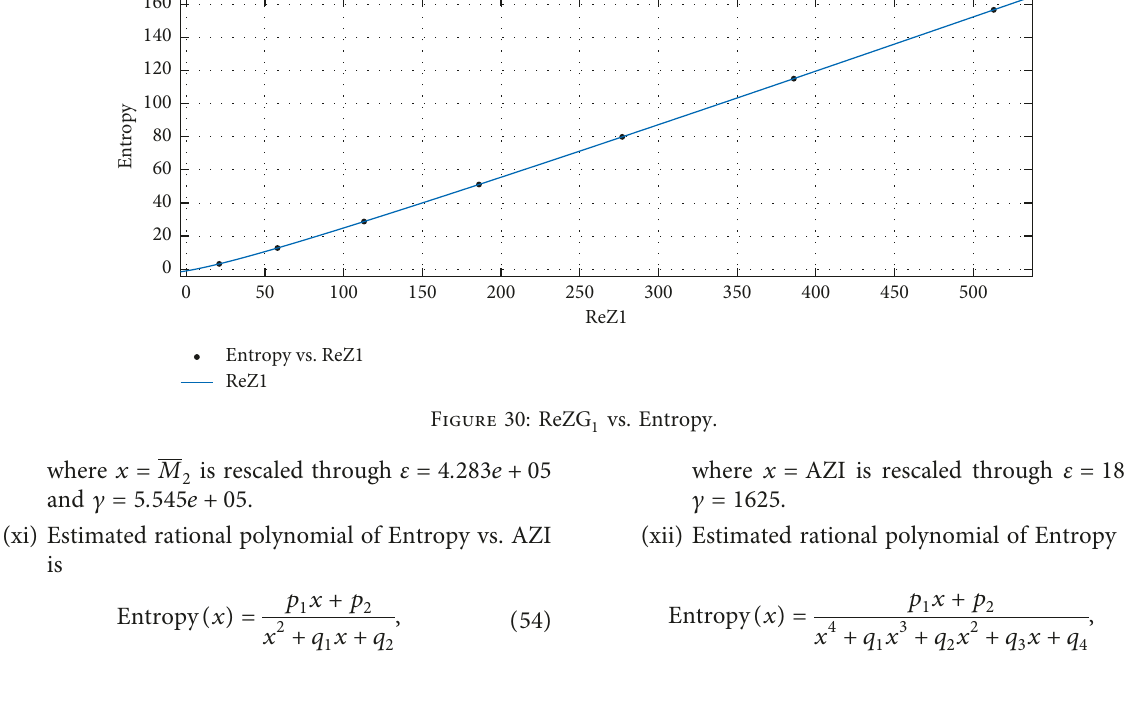
Figure 29: F vs. Entropy.